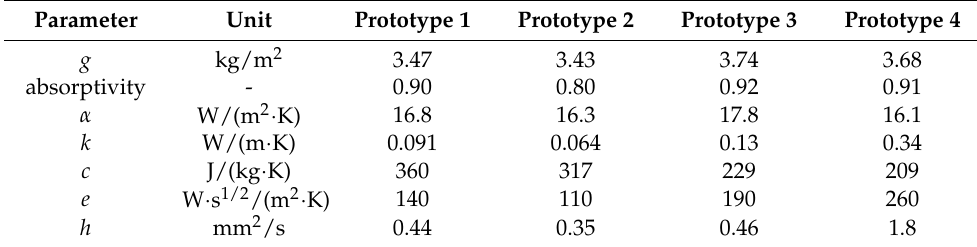
Table 7. Thermal parameters of each